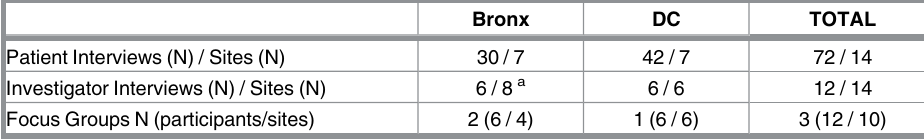
Table 2. Substudy participants and